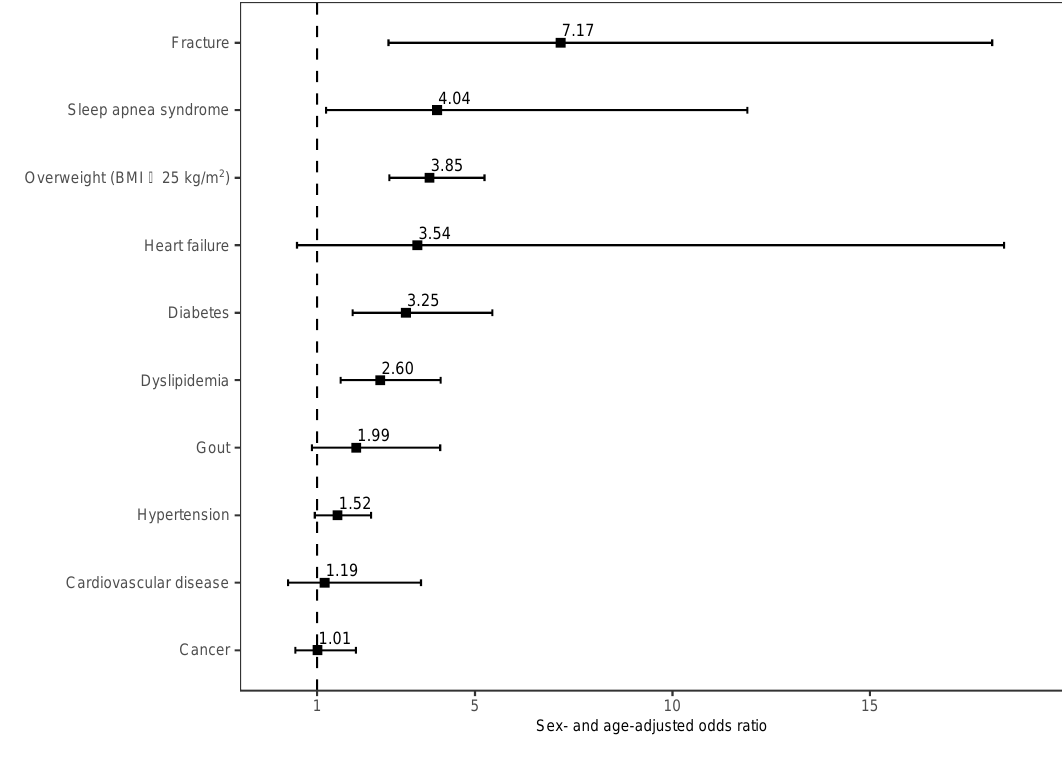
Figure 1. Sex- and age-adjusted odds ratios of participants with schizophrenia compared to participants without schizophrenia in terms of physical comorbidities. Abbreviations: BMI, body mass index. The reference group for overweight is normal BMI (18.5 – 24.9 kg/m 2 ).